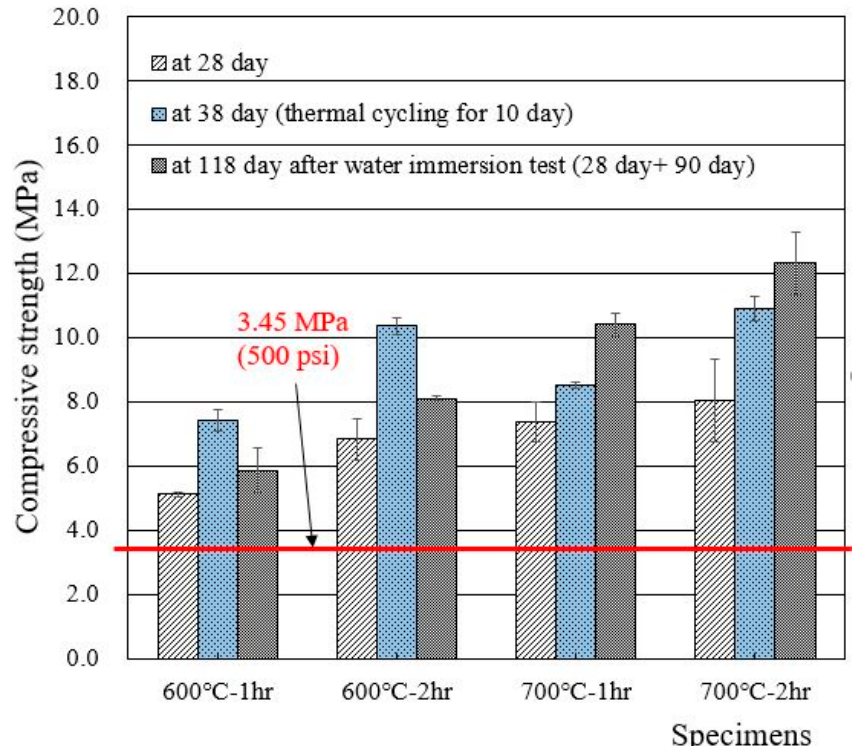
Figure 5. Compressive strengths of wasteform specimens made of deionized water and recycled cement powder that were heat treated at 600 and 700 °C.